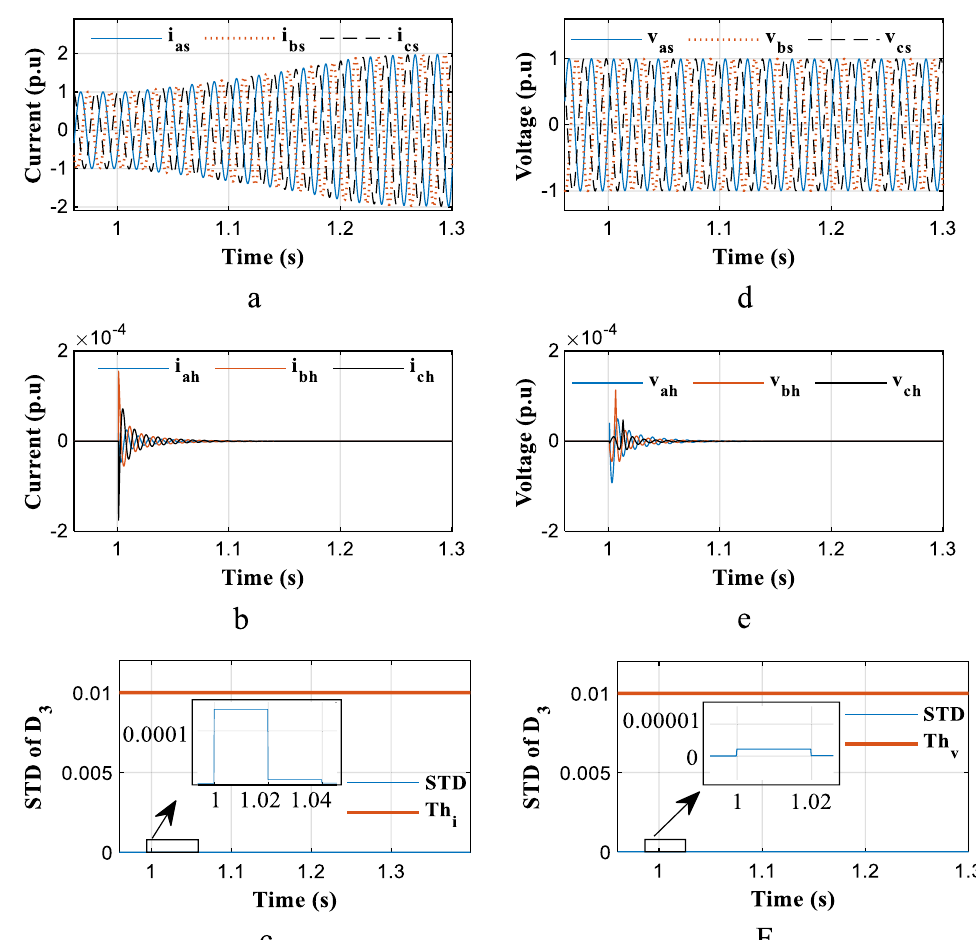
Fig. 13 Performance evaluation of proposed criteria using simulation results for a mechanical load change of 80%, a Three-phase stator current signals, b High-frequency components of three-phase stator current signals, c The current criterion, d Three-phase stator voltage signals, e High-frequency components of three-phase stator voltage signals, f The voltage